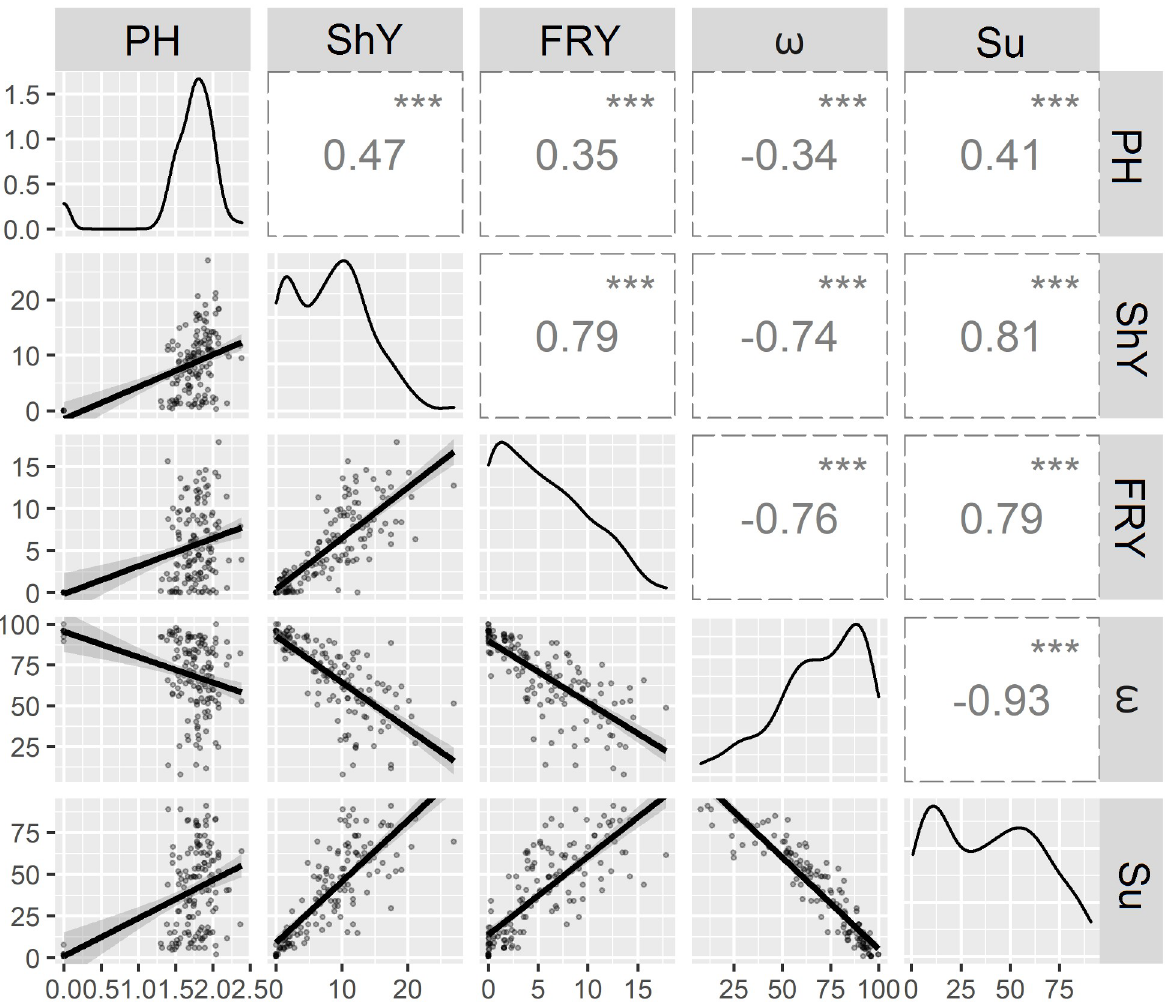
Fig 1. Pearson correlations with four agronomic traits derived from the evaluation of 148 cassava genotypes cultivated in areas infested by root rot pathogens. PH: plant height (m). ShY: shoot yield (t ha -1 ). FRY: fresh root yield (t ha -1 ). ω : disease index. Su: survival (%). Level of significance α : ��� = 0.001; �� =